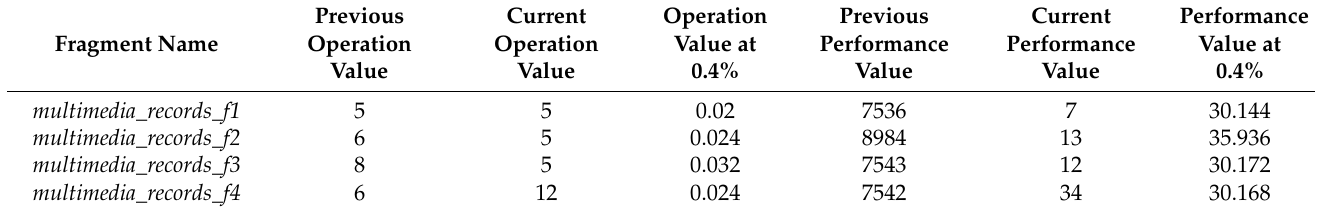
This evaluation uses 0.4% in both thresholds and is applied under two sites. Table 11 represents the calculation of the thresholds for each fragment. Table 11. Threshold analysis in dynamic fragmentation under the operations performed in Tables 9 and 10.